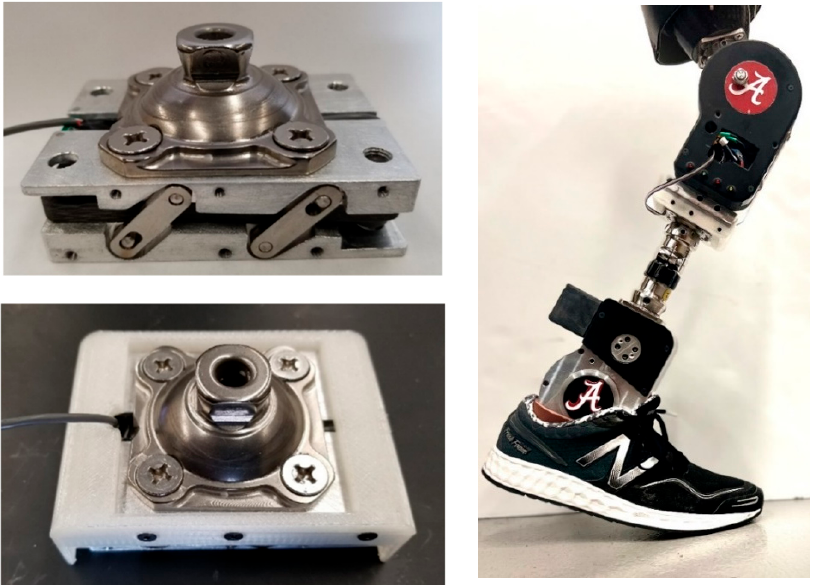
Figure 5. Prototype of the FM-PLS sensor ( left ) and FM-PLS fitted on a robotic prosthesis .